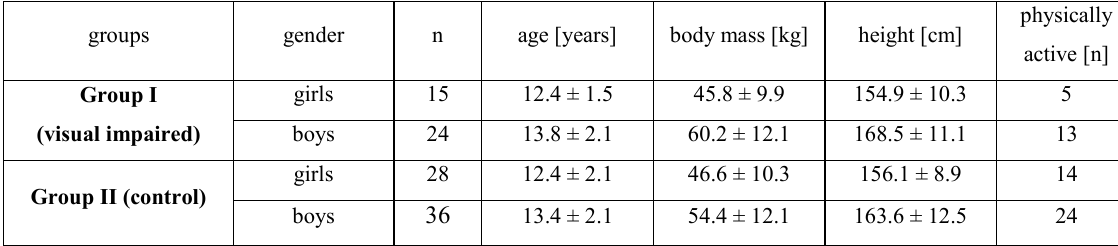
Characteristics of research groups (mean value ± standard deviation) groups gender n age [years] body mass [kg] Group I (visual impaired) Group II